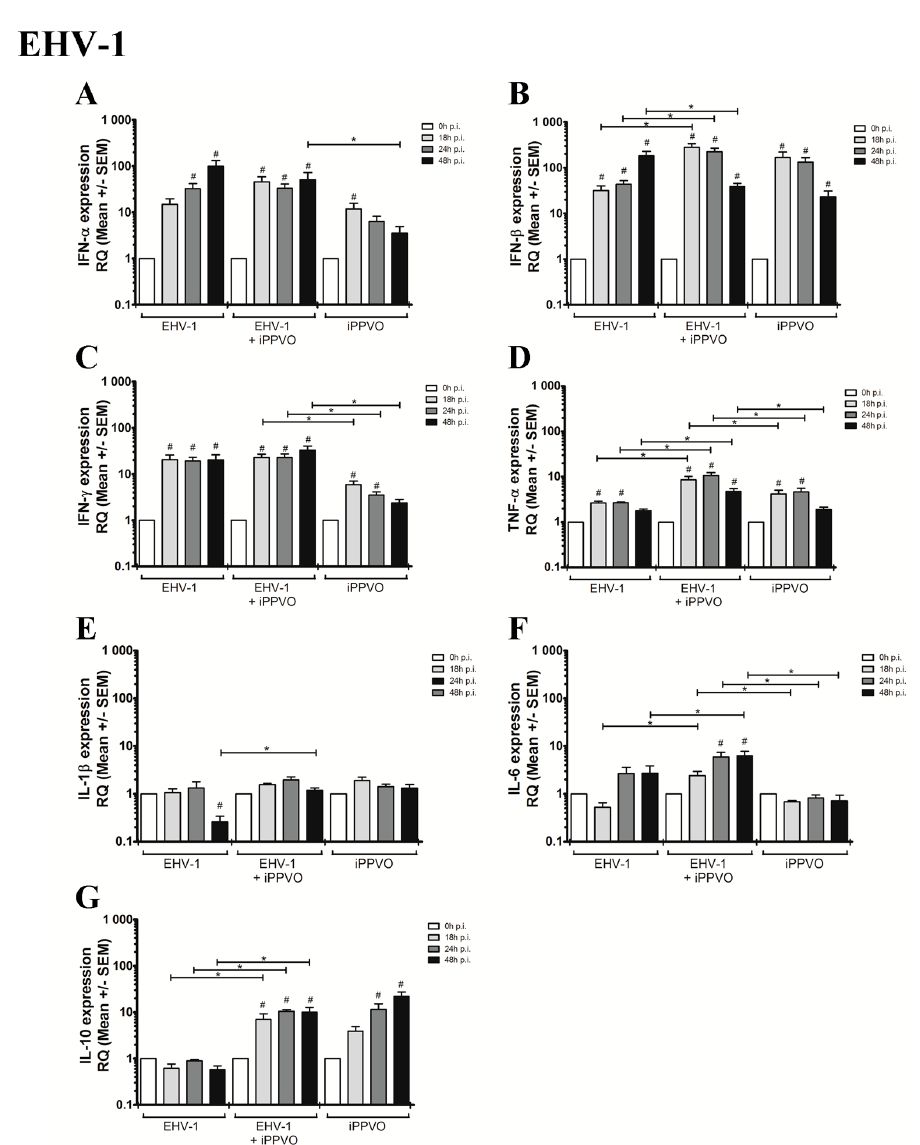
Figure 2. Cytokine mRNA expression measured by real-time PCR after infection of PBMC with EHV- 1 alone, after co-treatment iPPVO/EHV-1, and after iPPVO treatment. Cytokines measured were IFN- α ( A ), IFN- β ( B ), IFN- γ ( C ), TNF- α ( D ), IL-1 β ( E ), IL-6 ( F ), and IL-10 ( G ). White bars represent mRNA expression at 0 h (T 0 ), light grey bars represented mRNA expression at 18 hpi, dark grey bars at 24 hpi, and black bars at 48 hpi; n = 3 horses with 3 independent reverse-transcriptase PCR. Data are reported as means ± SEM as fold increase over the T 0 . The level of significance was set as p -value < 0.05. Significant differences compared to T 0 are indicated by # and differences between all conditions by star ( p < 0.05). The iPPVO/EHV co-infection condition was compared with EHV infection alone or iPPVO treatment alone.